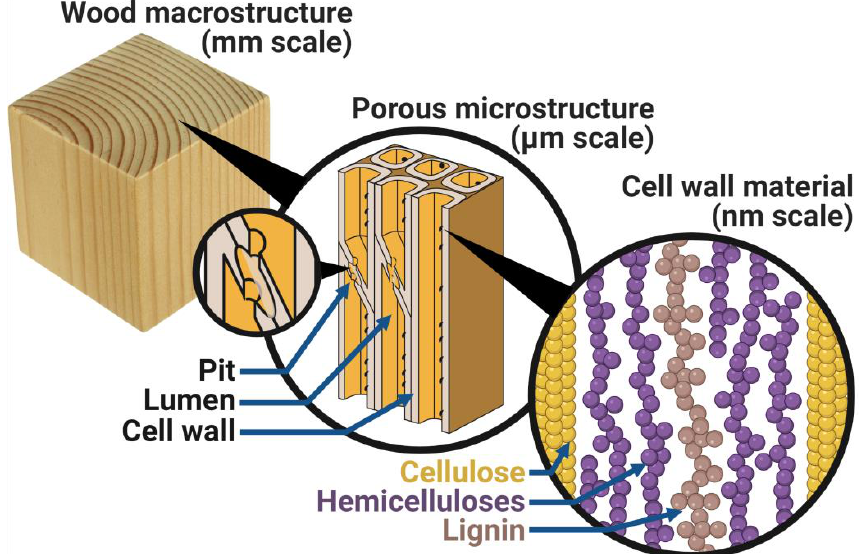
Figure 1. Simplified overview of wood structure on different length scales: Wood macrostructure with annual rings; porous microstructure with pits, which are pathways through cell walls that connect lumina (singular: lumen) of adjacent cells; and cell wall material made from cellulose, hemicelluloses, and lignin.